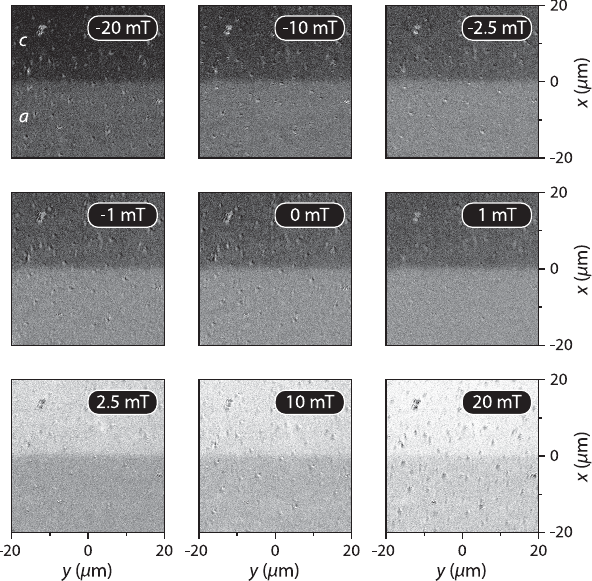
FIG. 2. Kerr-microscopy images of magnetization reversal in an Fe film on top of a BaTiO 3 substrate. The in-plane magnetic field and the axis of magneto-optical Kerr-effect contrast are aligned perpendicular to the domain